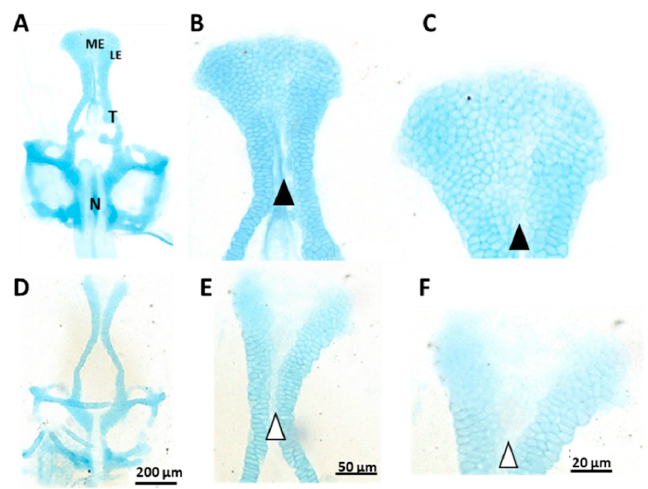
Figure 3. Comparing the mean tooth length in the control and 1% alcohol-treated samples at 15, 20 and 25 days post-fertilisation (dpf) ( A ). Comparing the mean tooth width in control and 1% alcohol-treated samples at 15, 20 and 25 dpf ( B ).